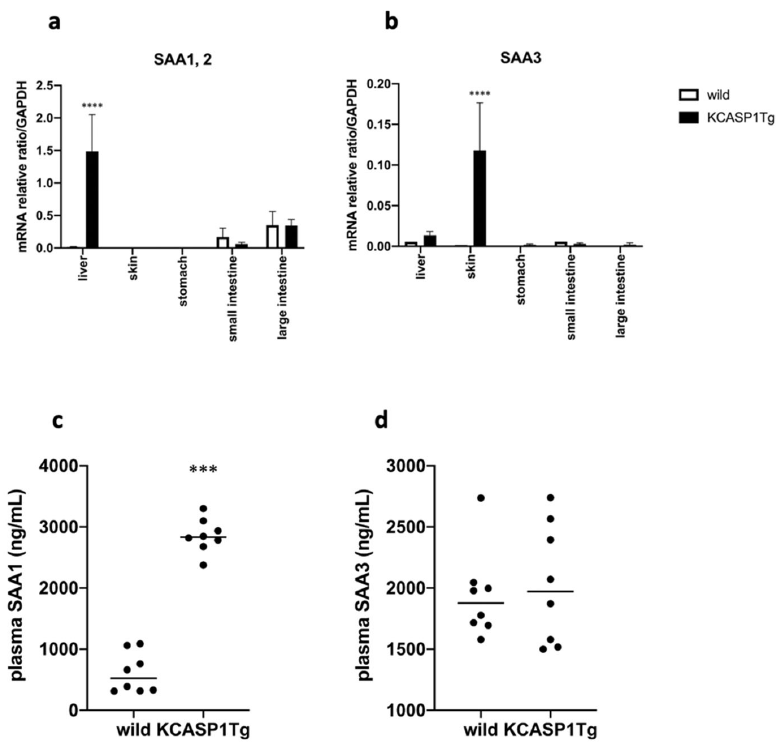
Figure 4. SAA levels in organs and plasma. ( a ) The mRNA purified from various organs in the KCASP1Tg and WT mice revealed that there was a higher production of SAA1 and SAA2 in the liver of the KCASP1Tg than in the WT mice. ( b ) An increased level of SAA3 was detected in the skin of the KCASP1Tg mice. ( c , d ) The plasma levels of SAA1 were higher in the KCASP1Tg mice than in the WT littermates; however, the plasma levels of SAA3 were similar between the two groups. All data are expressed as means ± SDs. *** p < 0.001, **** p < 0.0001 compared to wild mice